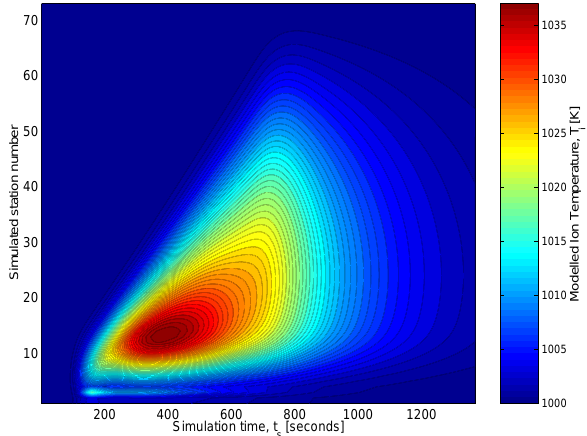
Fig. 7. A formedogram showing the ion temperature response with time, at various MLT (for a fixed latitude, here 67 ◦ ). The scenario modelled is for a single burst of reconnection, starting at t s = 60s and having a duration of 1min at all MLT from 12 MLT to 10 MLT (in bins of (360/256) ◦ ). The expansion velocity of the X-line foot- print at 67 ◦ latitude is 10 ◦ min − 1 . The station numbered 1 is at 12 MLT and station number 72 is at 0 MLT.